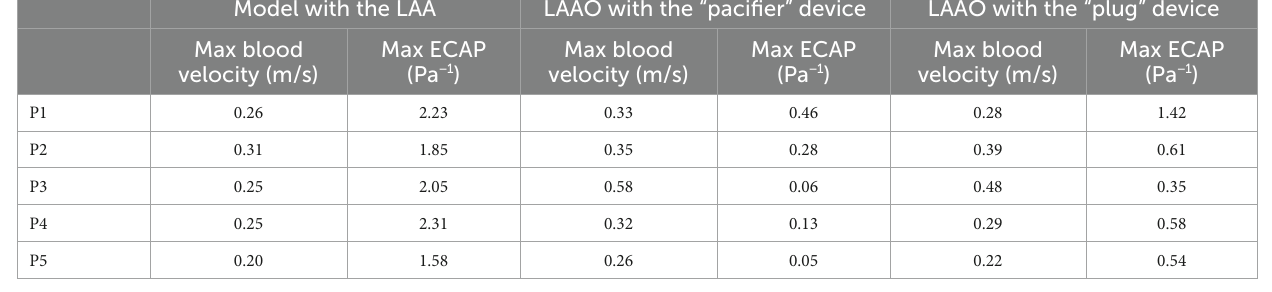
TABLE 4 Max blood velocity and max ECAP value in the volume near the implanted device in the simulations performed in the five patients enrolled in the study. Model with the LAA LAAO with the “pacifier” device LAAO with the “plug” device